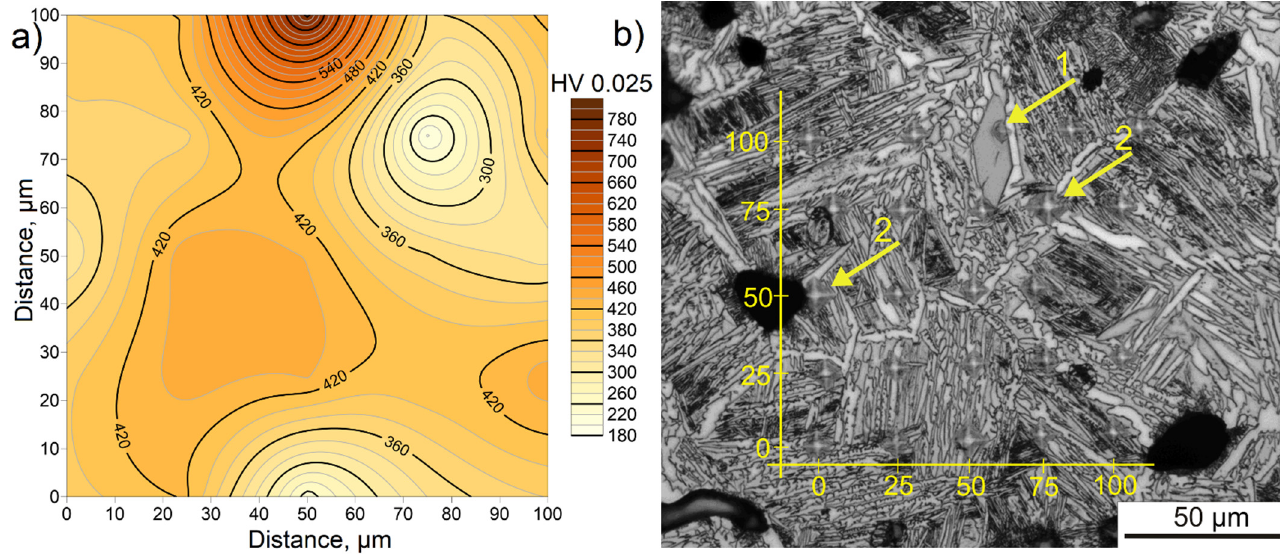
Figure 7. ( a ) Micro-hardness map and ( b ) corresponding microstructure.